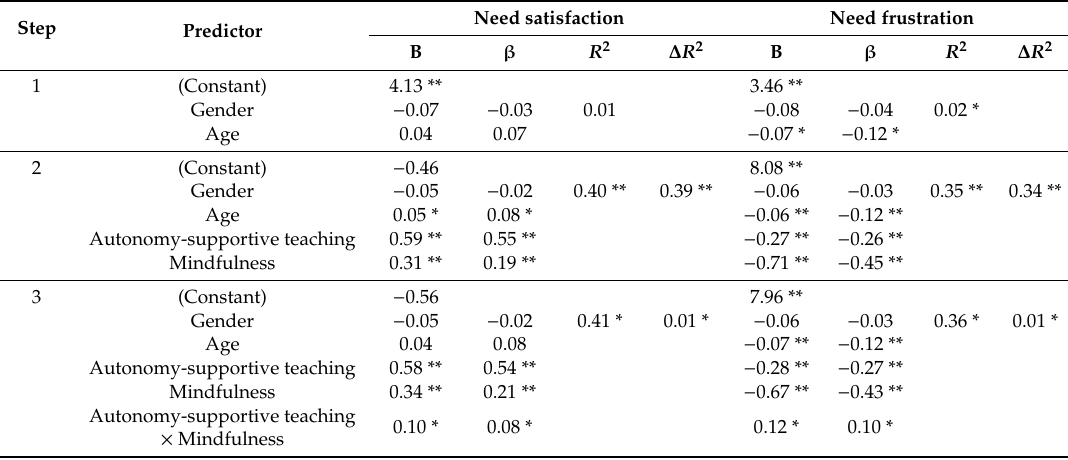
Table 2. Results of multiple regression analyses.